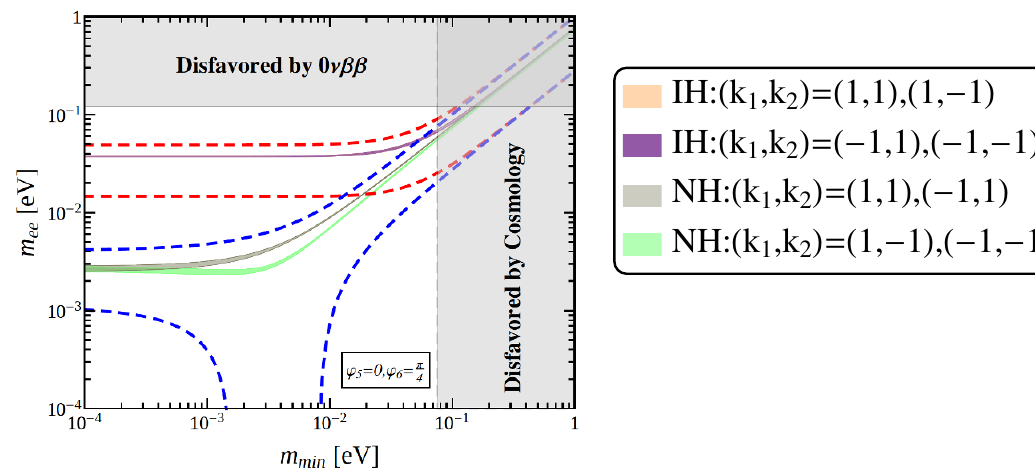
Figure 10 . The possible values of the e(cid:11)ective Majorana mass m ee as a function of the lightest neutrino mass m min for the mixing patterns U III ; 1 and U III ; 3 . The red (blue) dashed lines indicate the most general allowed regions for IH (NH) neutrino mass spectrum obtained by varying the mixing parameters over their 3 (cid:27) ranges [8]. The present most stringent upper limits m ee < 0 : 120 eV from EXO-200 [85, 86] and KamLAND-ZEN [87] is shown by horizontal grey band. The vertical grey exclusion band denotes the current bound coming from the cosmological data of P m i < 0 : 230 eV at 95% con(cid:12)dence level obtained by the Planck collaboration